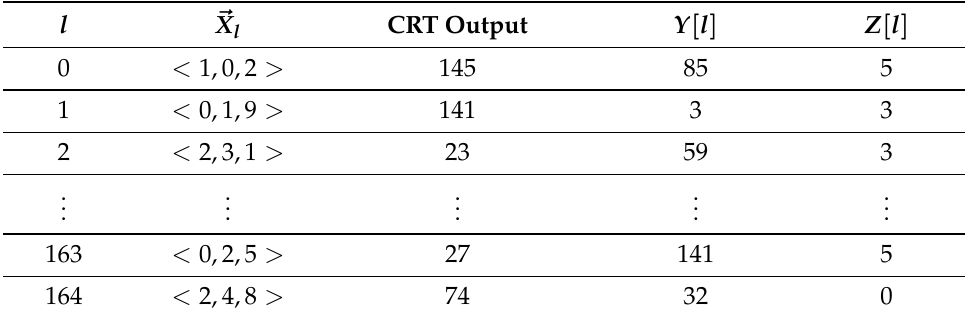
Table 2. Data from the toy